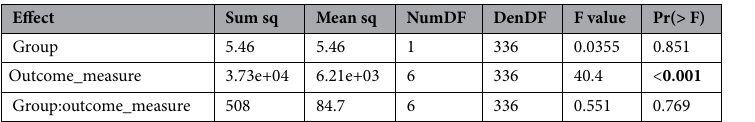
Table 6. After Magnitude ANOVA: results of the mixed model for the magnitude of asymmetry of the gait parameters at the beginning of the after condition [lmer Eq. (3)]. Bolded p-values indicate significance of the corresponding factor. The group factor refers to the younger and older adult categories and the outcome measure factor refers to the different gait parameters.